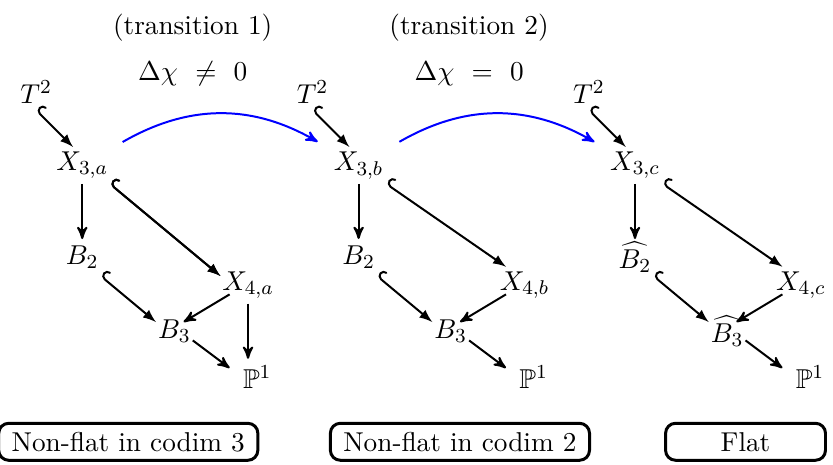
Figure 2 . Summary of a chain of conifold transitions in elliptic four-folds. The starting four-fold X 4 ,a is constructed from a three-fold X 3 ,a fibered over a P 1 . We then perform conifolds in four- folds inherited from the three-folds. Conifold 1 renders X 4 ,b non-flat and conifold two removes the non-flat fiber again by a birational base change